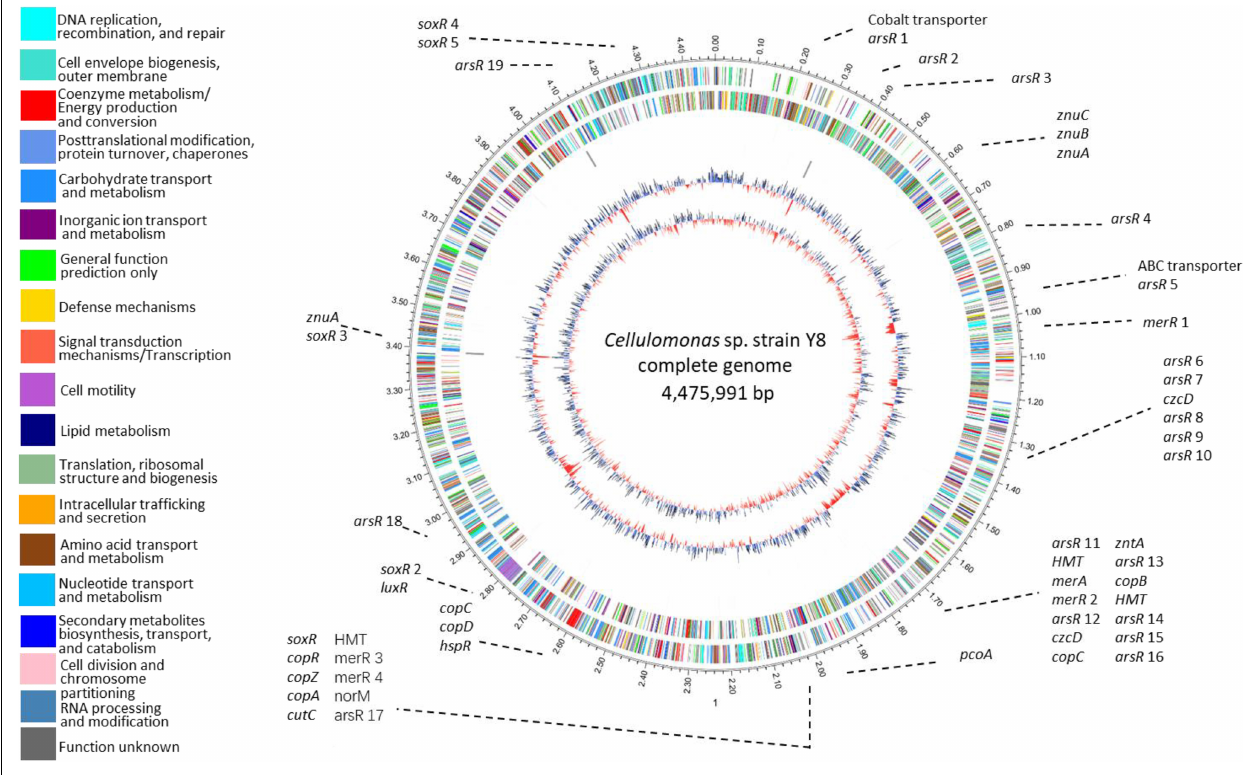
Frontiers in Microbiology |